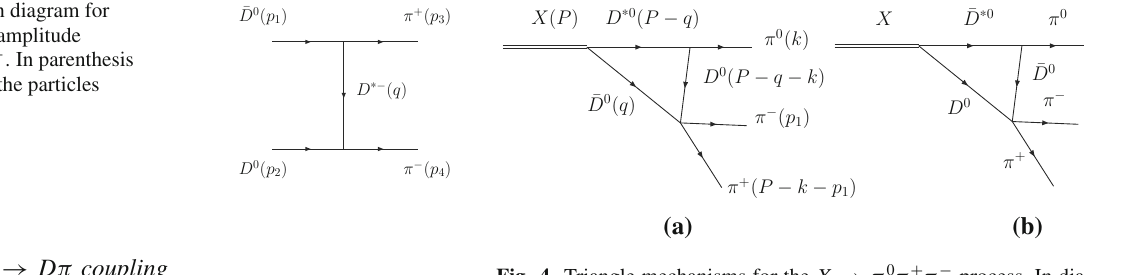
Fig. 4 Triangle mechanisms for the X → π 0 π + π − process. In